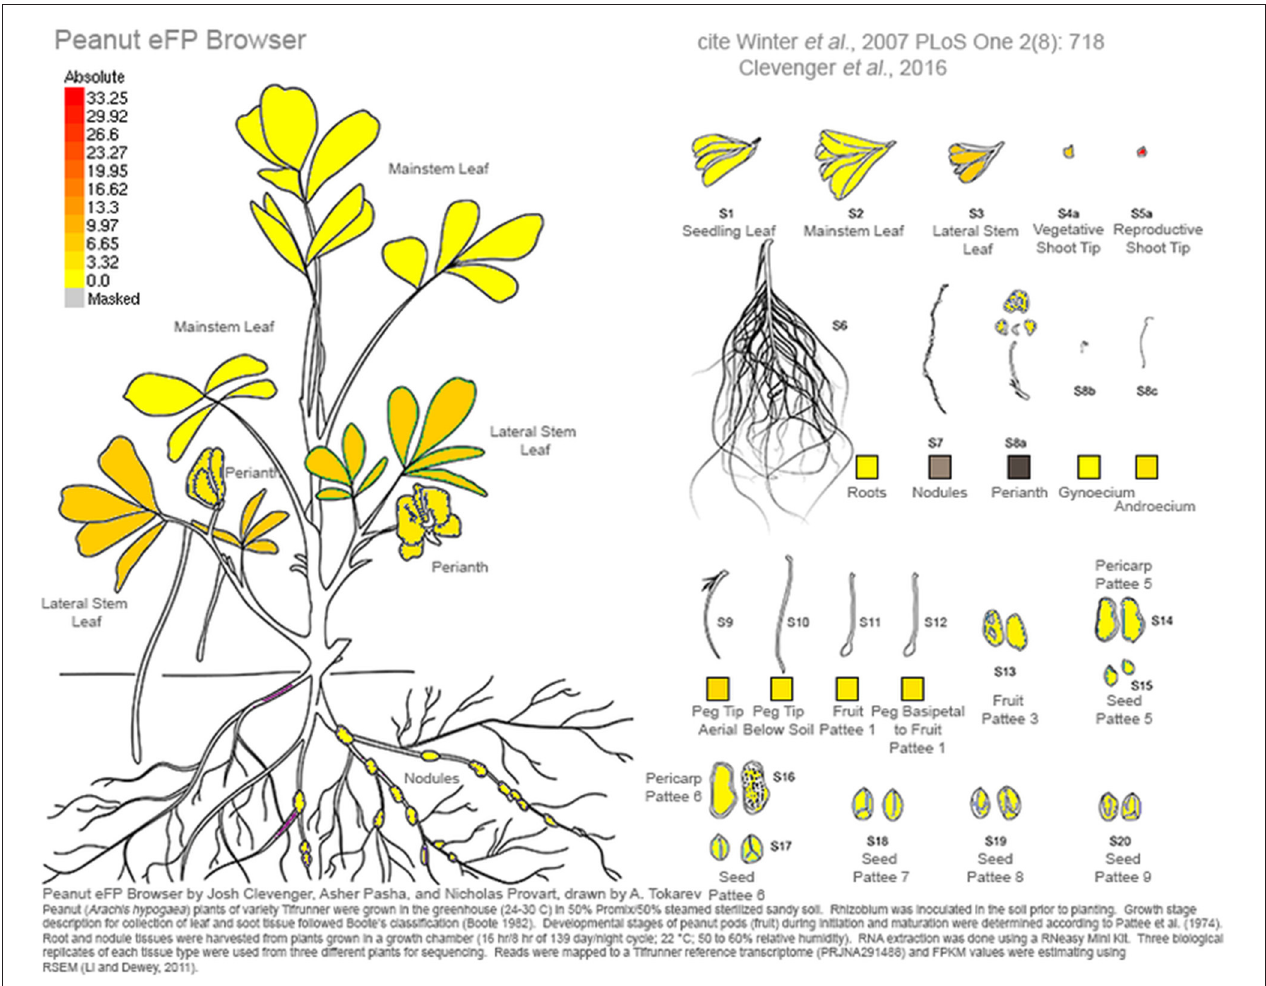
FIGURE 8 | Screen shot from the Arachis eFP browser showing expression for the putative ortholog of Hd3a and it’s enriched expression in reproductive shoot tips. Expression is in